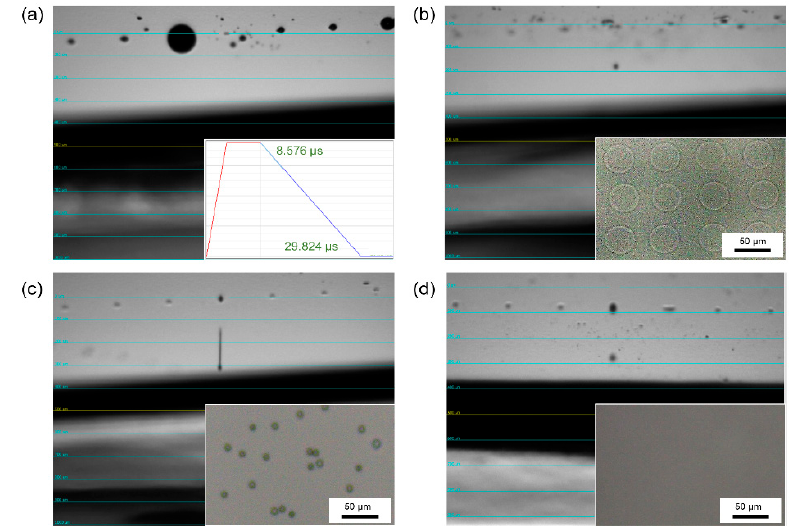
Figure 2. Jetting behaviors of ( a ) the m-PEDOT:PSS ink (Inset: The waveform of DI water), ( b ) the m-PEDOT:PSS ink with DI water, ( c ) the m-PEDOT:PSS ink with EG, and ( d ) the m-PEDOT:PSS ink with EG and DI water (Inset: the optical microscopy images of inkjet-printed dots).